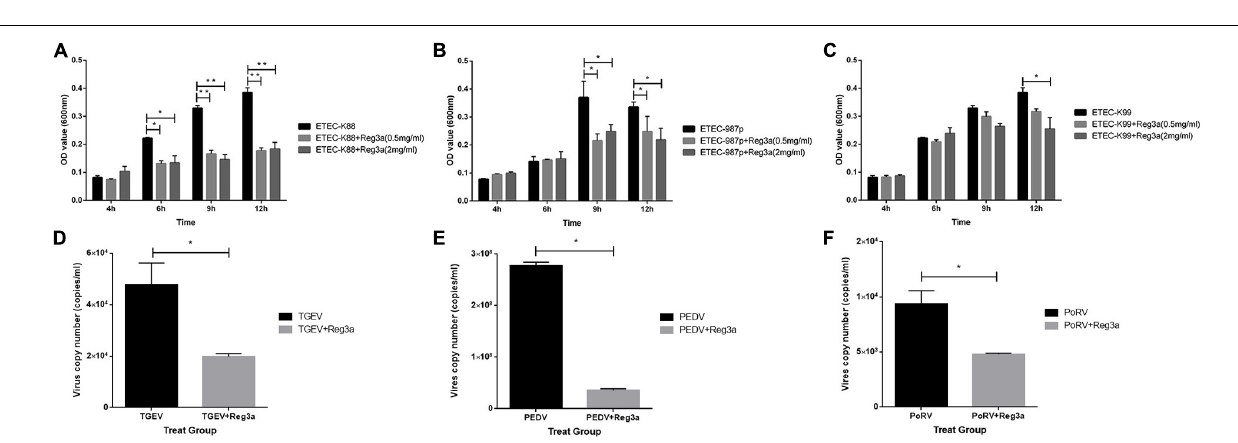
FIGURE 7 | Effect of the expressed antimicrobial peptide on bacteria and virus. For understanding the effect of m Reg3a on bacteria and viruses, we used ETEC-K88 (A) , ETEC-987p (B) , ETEC-K99 (C) , TGEV (D) , PEDV (E) , and PoRV (F) , which are often found in infected piglets, to co-culture with Reg3a protein. Error bars indicated standard deviations. * p < 0.05, ** p < 0.01, and *** p < 0.001 using by Student’s t -test was used to evaluate differences between every two